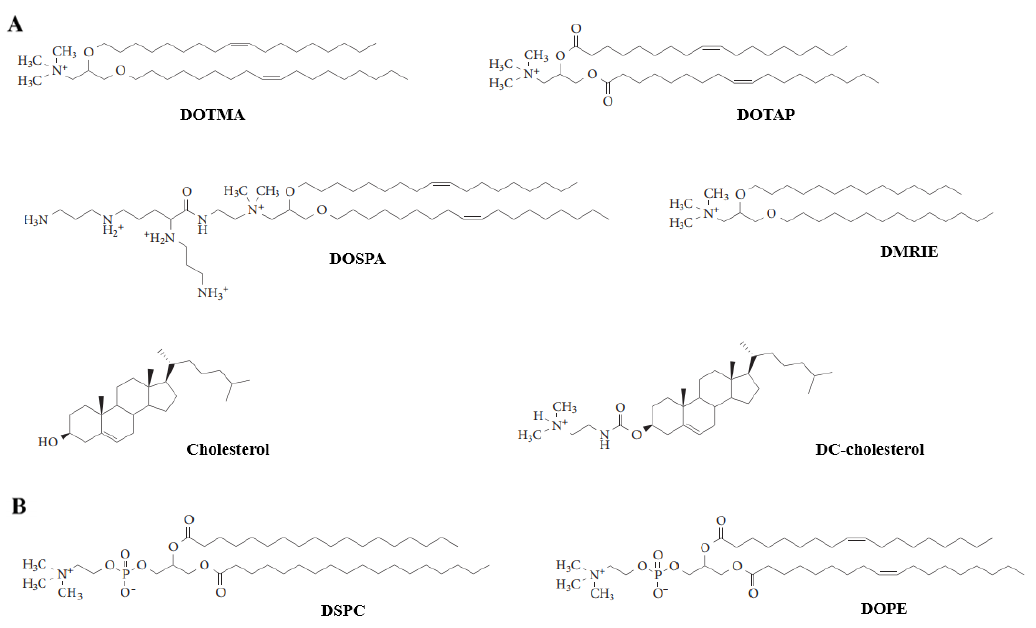
Figure 4. Chemical structures of lipid-based vectors [12]. ( A ) Cationic lipids and ( B ) neutral lipids.